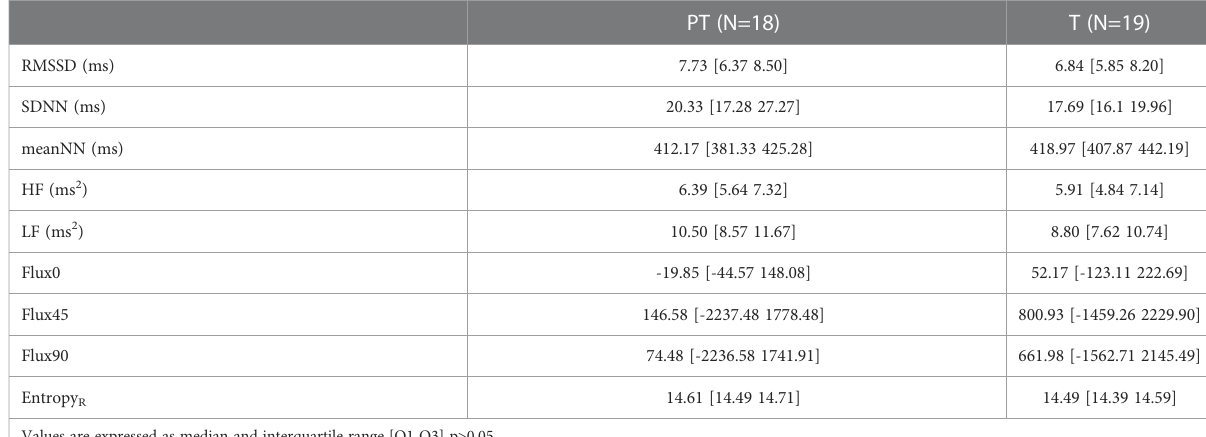
TABLE 2 Values of linear, nonlinear, and time-frequency indices of short-term fetal heart rate variability (FHRV) calculated over 20 minutes segments for Term (T) and Preterm (PT) groups.